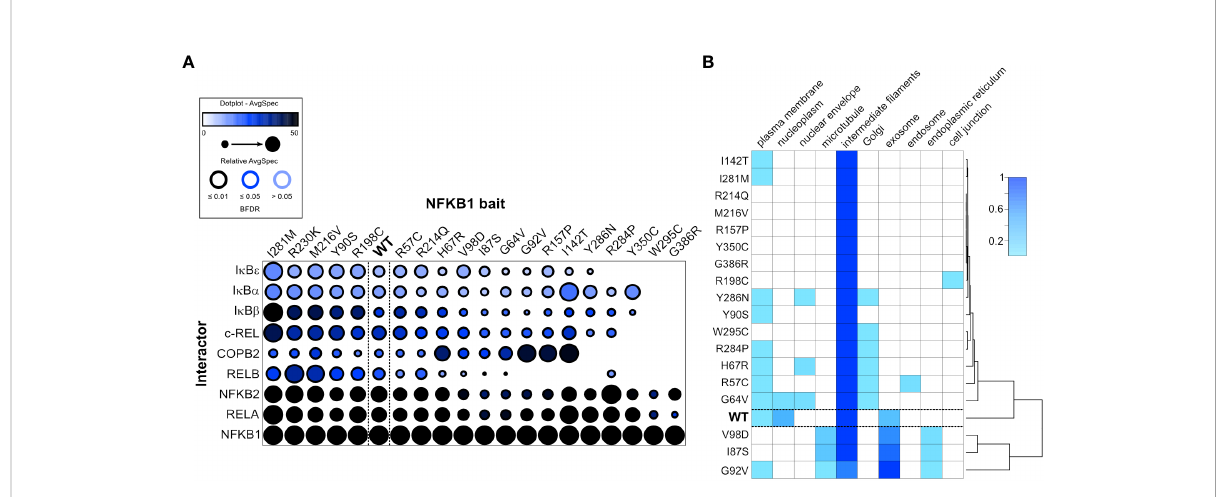
FIGURE 6 NFKB1 missense variants cause protein interaction defects and subcellular mis-localization. (A) Dotplot of selected p105/p50 interactors illustrates the protein interaction changes induced by single amino acid variants. The order of the NFKB1 baits is based on hierarchical clustering. (B) The heatmap shows the molecular context of NFKB1 variants based on the annotation score of the MS-microscopy system. The cluster tree (right side) indicates common